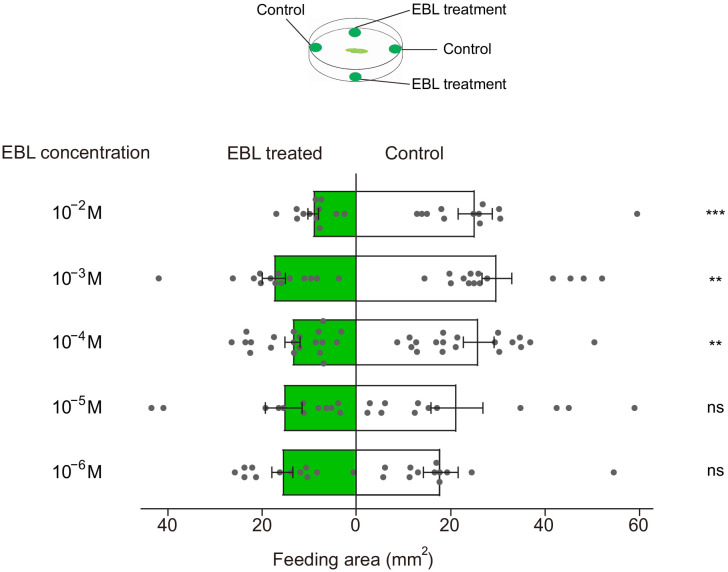
24-Epibrassinolide (EBL)-induced feeding deterrence effect on P. xylostella larvae.Dual-choice feeding tests were conducted using pea leaf discs. Total feeding area of control (white bars) and EBL-treated discs (green bars). EBL was diluted in 50% ethanol to 10−6, 10−5, 10−4, 10−3, and 10−2 M. Data are mean ± SEM. For 10−6 M, n = 12, p=0.5151; 10−5 M, n = 12, p=0.336; 10−4 M, n = 20, p=0.0024; 10−3 M, n = 14, p=0.0023; 10−2 M, n = 12, p=0.0004. Data were analyzed by paired-samples t-test.Figure 6—figure supplement 1—source data 1.Source data for Figure 6—figure supplement 1.